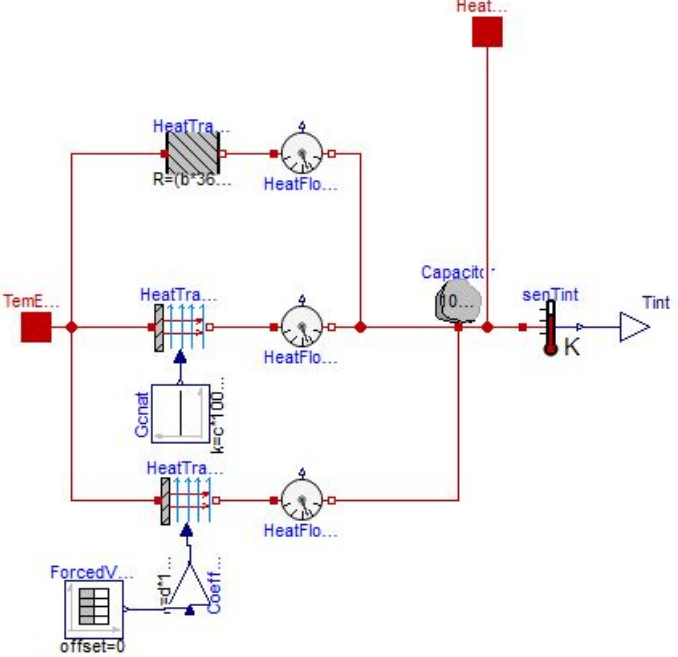
Figure 4. Diagram view of “RCBuilding” model component in Dymola. Table 2. Performance coefficients of buildings supplied by “Nuova Sud” network.